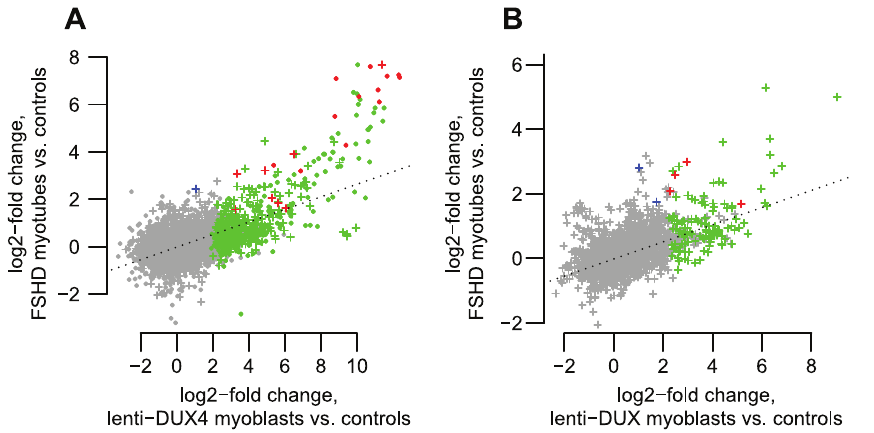
Figure 7. DUX4-bound regions are similarly activated in FSHD patient myotubes and in DUX4 -transduced myoblasts. (A) DUX4-bound regions show correlated activation levels in FSHD patient myotubes and in our DUX4 -transduced myoblast experimental system. We show log2- activation levels in each system, counting RNA-seq reads within an arbitrary 1 kb of DUX4-bound regions as for Figure 3A. ‘‘ + ’’ symbols show bound repetitive elements and dot symbols are unique regions. Green symbols show regions that reach statistical significance in only the DUX4 -transduced myoblasts, blue symbols are significant in only the FSHD myotubes, and red symbols are significant in both comparisons. The dotted line is a regression line (slope 0.265). (B) Internal regions of ERV and MaLR repeats show correlated activation levels in FSHD patient myotubes and in our DUX4 -transduced myoblast experimental system. Colors as in panel A. The dotted line is a regression line (slope 0.270).